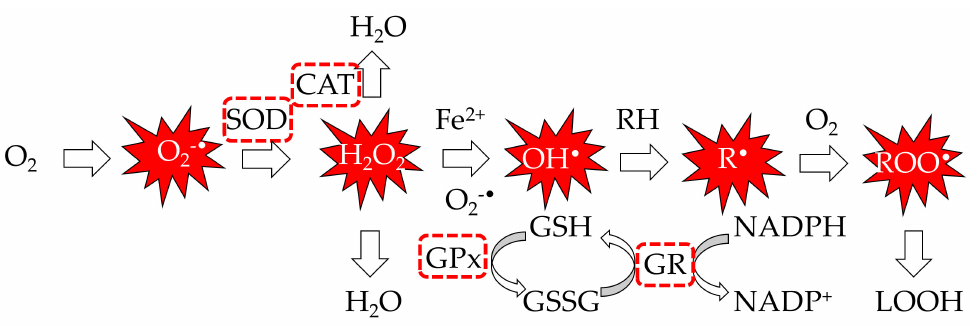
Figure 4. Reactions and enzymes involved in reactive oxygen species (ROS) generation and propagation analyzed in chlorophyll antioxidant studies: superoxide (O2 ·− ), hydroxyl (OH · ), peroxyl (RO 2 · ), and hydrogen peroxide (H 2 O 2 ). Antioxidant enzymes: SOD: superoxide dismutase, CAT: catalase, GPx: glutathione peroxidase, GR: glutathione reductase, GSH / GSSG: reduced / oxidized